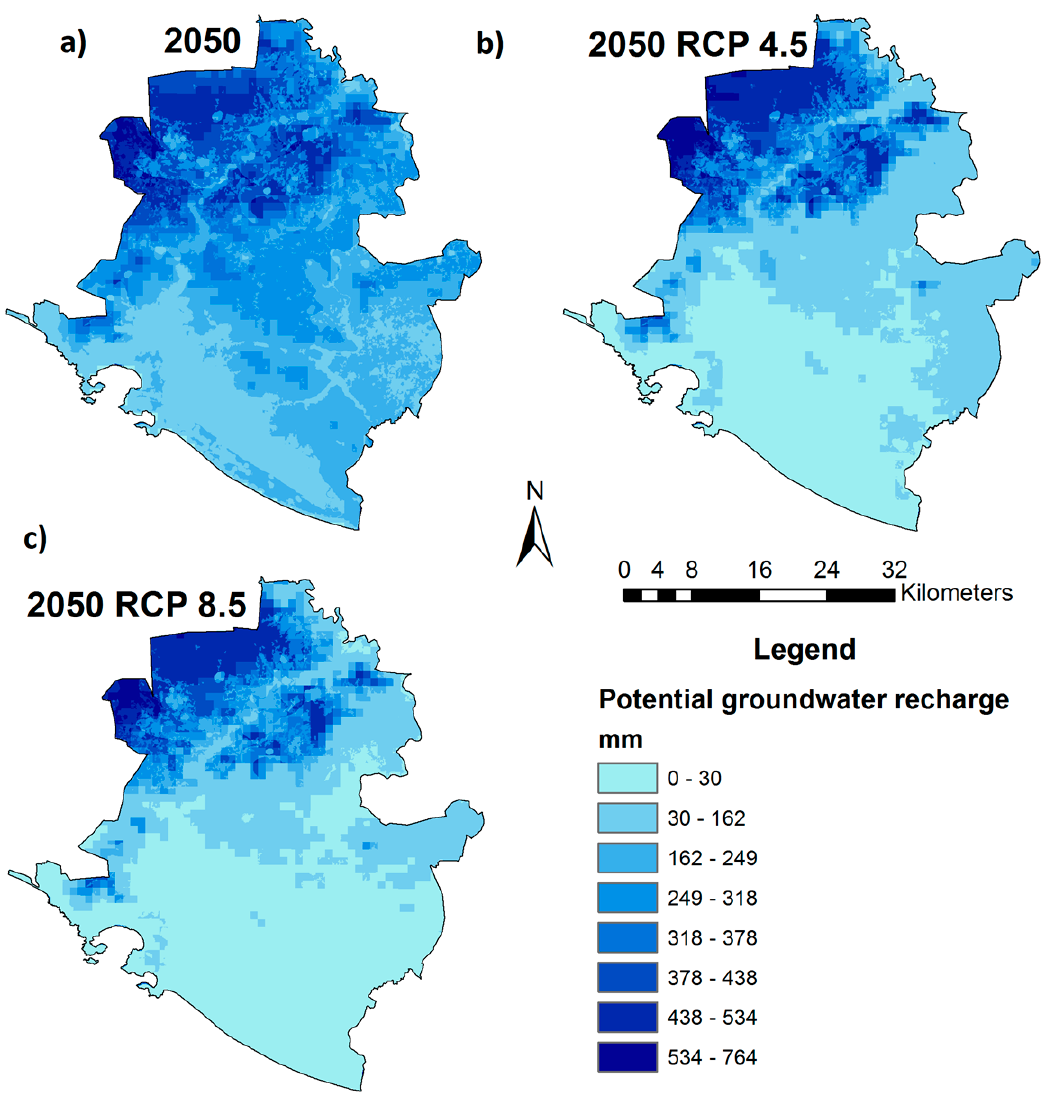
Figure 7. Potential groundwater recharge for 2050 with climatic variables; ( a ) current weather conditions, ( b ) RCP 4.5 and ( c ) RCP 8.5 weather conditions predicted by the IPCC for 2050.